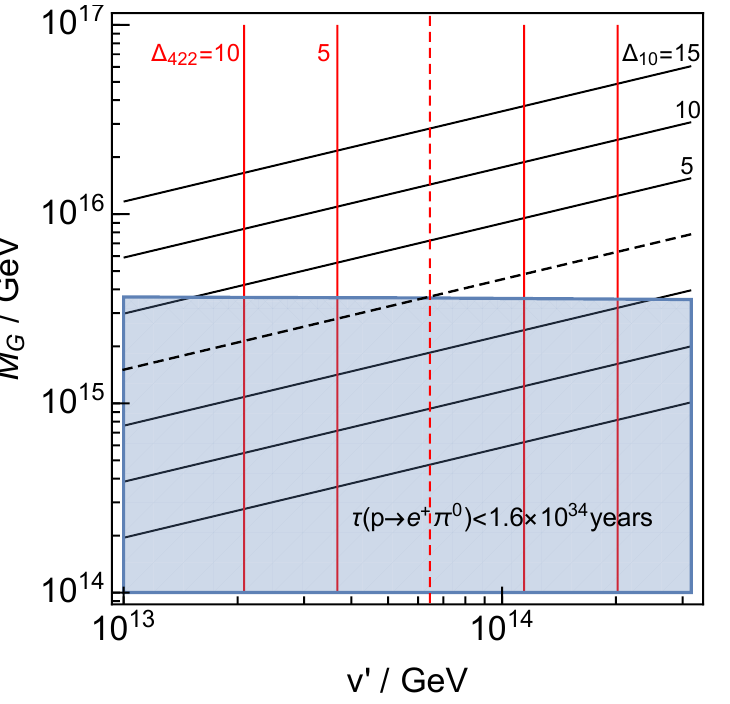
Figure 3 . The quality of gauge coupling uni(cid:12)cation as a function of v 0 and the uni(cid:12)cation scale M G .